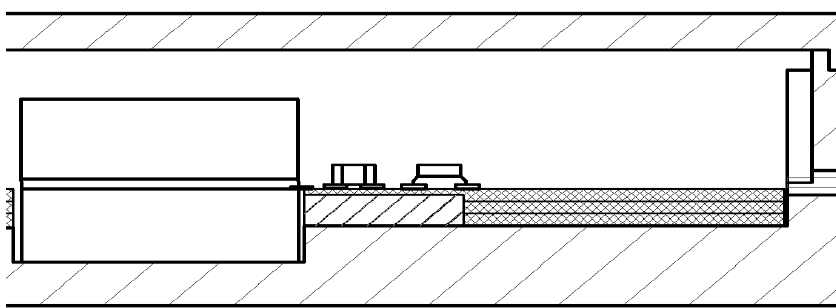
Fig. 4. The sampling circuit in ML PCB.